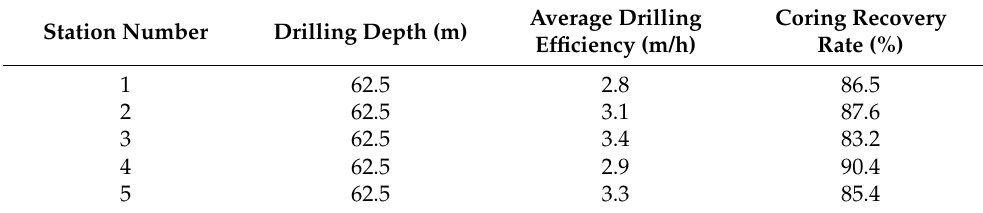
Figure 14. Field application of diamond bit in seafloor coring drilling, ( a ) seafloor drill deployment operation; ( b ) used diamond bits; ( c ) core samples. Table 6. Drilling operation.